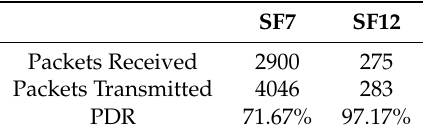
Figure 11. RSSI reception levels (dBm) in the port area with LoRa’s SF12. Table 2. Packet Delivery Ratio (PDR) in the port